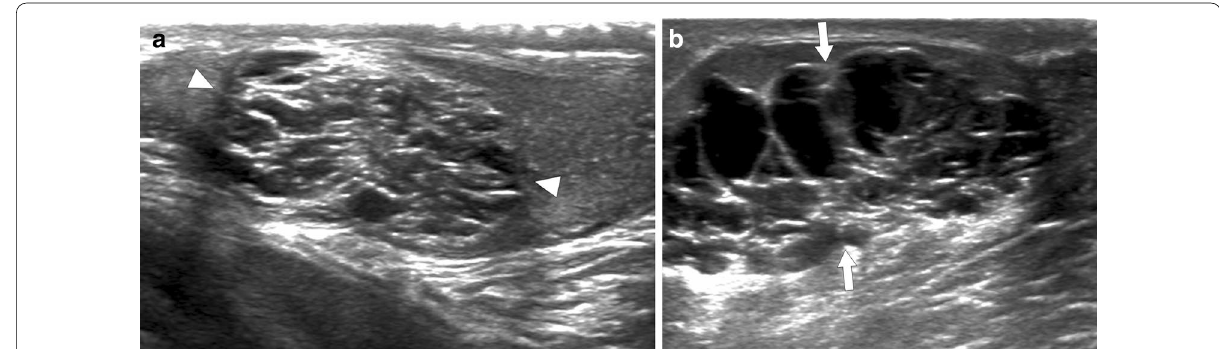
Fig. 20 Cystic dysplasia of the rete testis in two different patients with known ipsilateral multicystic dysplastic kidney. a A 3-year-old boy with palpable right testicular mass. Gray scale testis US showed well-defined multicystic lesions within the right mediastinum testis. The lesion contains serpiginous tubular anechoic areas with intervening echogenic septations (arrowheads). No internal vascularity was detected on color flow Doppler US exam (not shown). Cystic dysplasia of rete testis was considered due to patient demographics and history. The lesion was stable on his last follow-up US exam 2 years after initial presentation. b A 7-year-old boy presenting with left testicular swelling. Gray scale US image shows a large multicystic lesion almost completely replacing the left testis parenchyma (arrows). Again the patient demographics, history and imaging findings were consistent with cystic dysplasia of the rete testis. Findings were stable on serial follow-up US